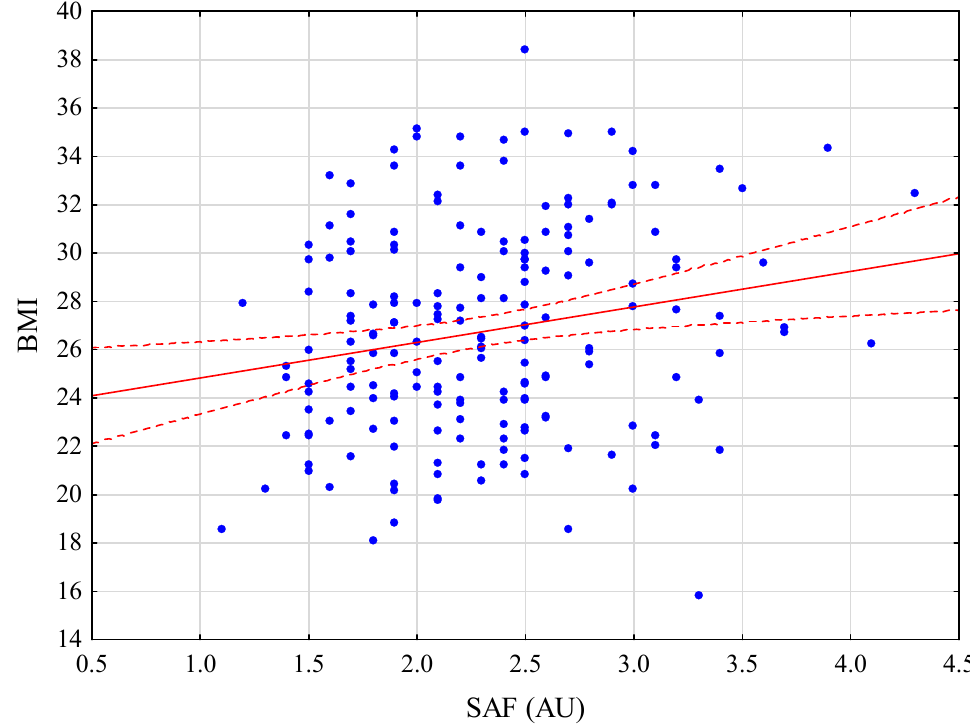
Figure 2. Correlation between skin autofluorescence (SAF) and body mass index (BMI).